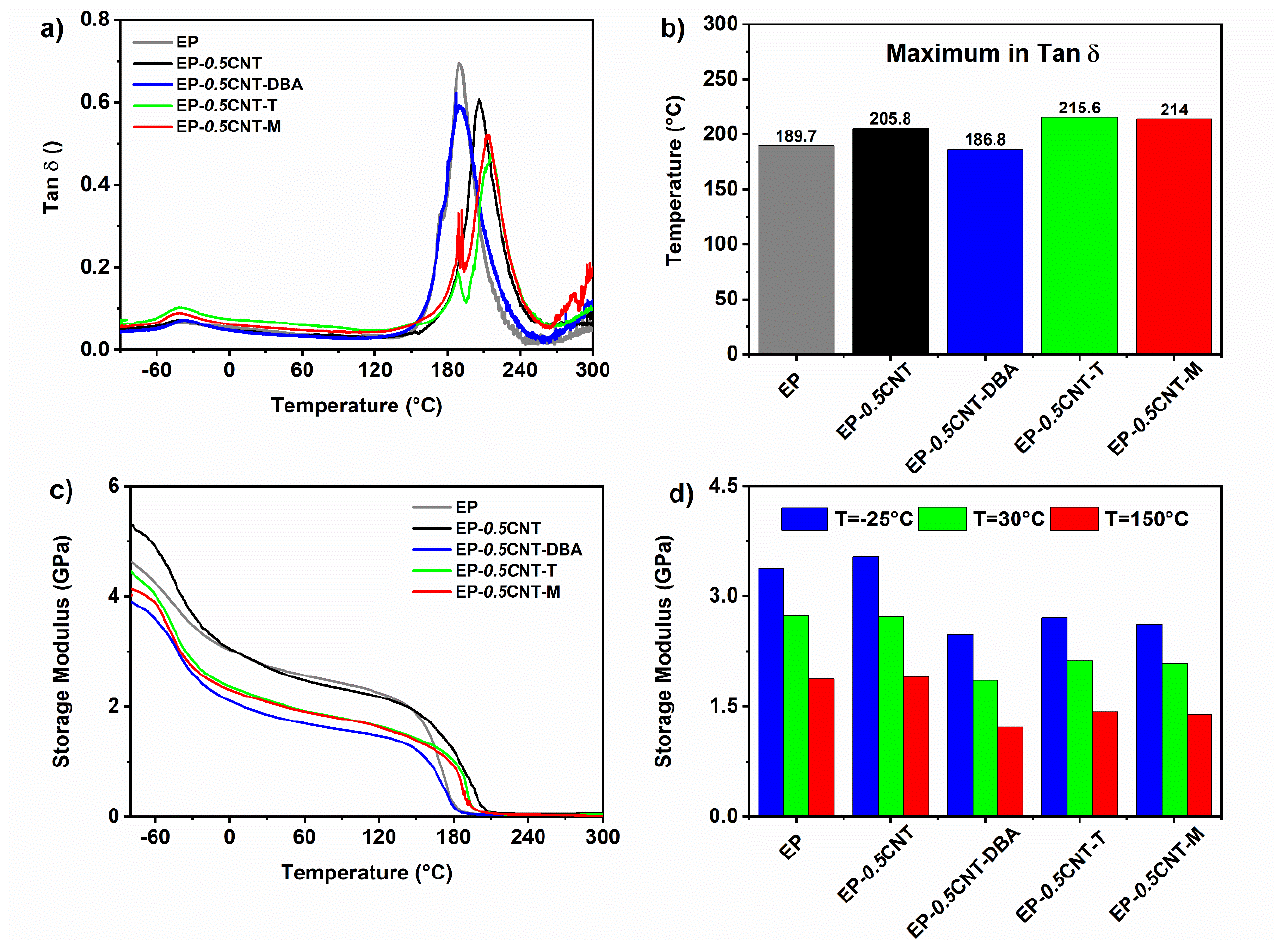
Figure 11. Results from the DMA analyses of the analyzed samples: ( a ) Tan δ curves as a function of temperature; ( b ) Temperatures of the maximum in Tan δ ( c ) storage modulus as a function of temperature; ( d ) storage modulus at different temperatures (−25, 30 and 150 °C).